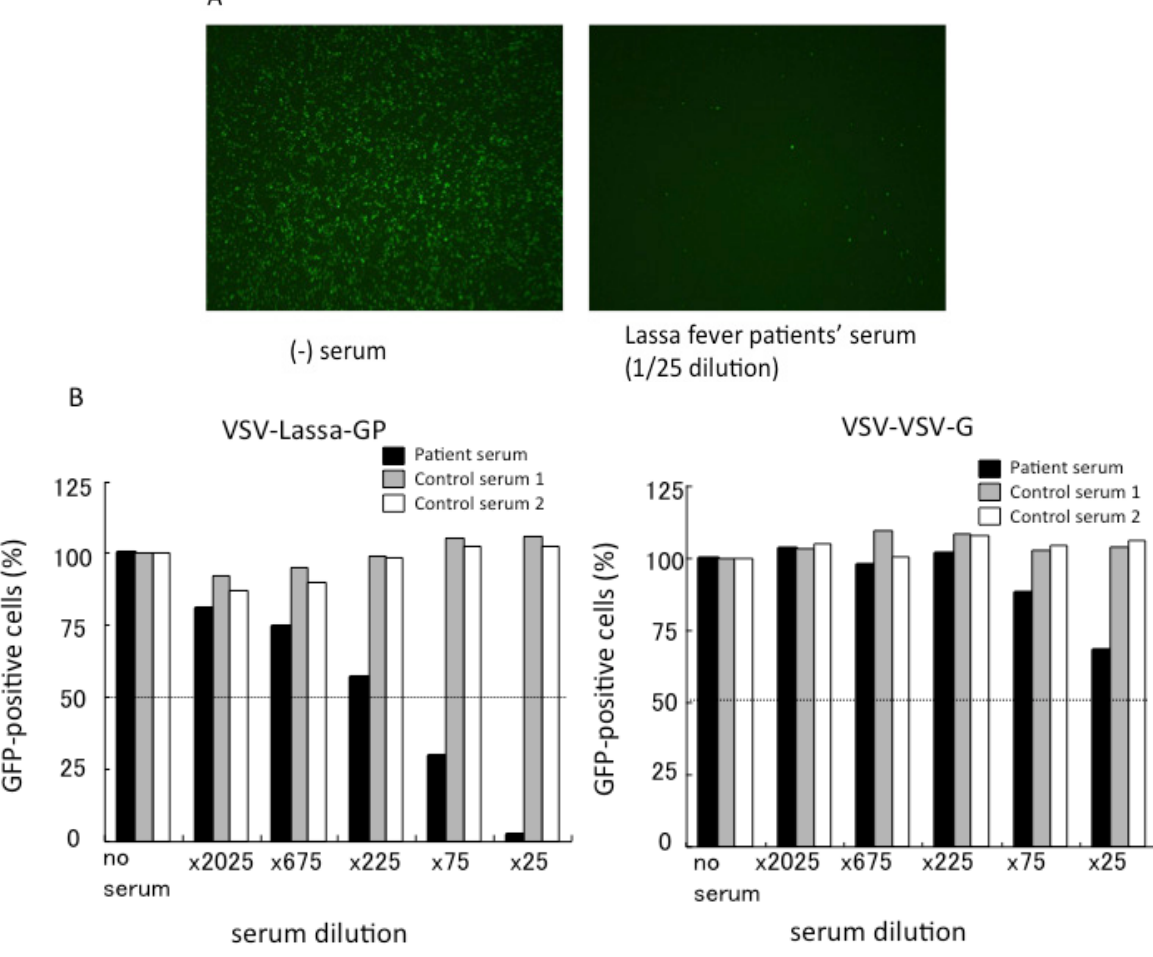
Figure 4. Neutralization assay for VSV-Lassa-GP. ( A ) VSV-LAS-GP was incubated with or without serum obtained from a Lassa patient, and then was inoculated into Vero